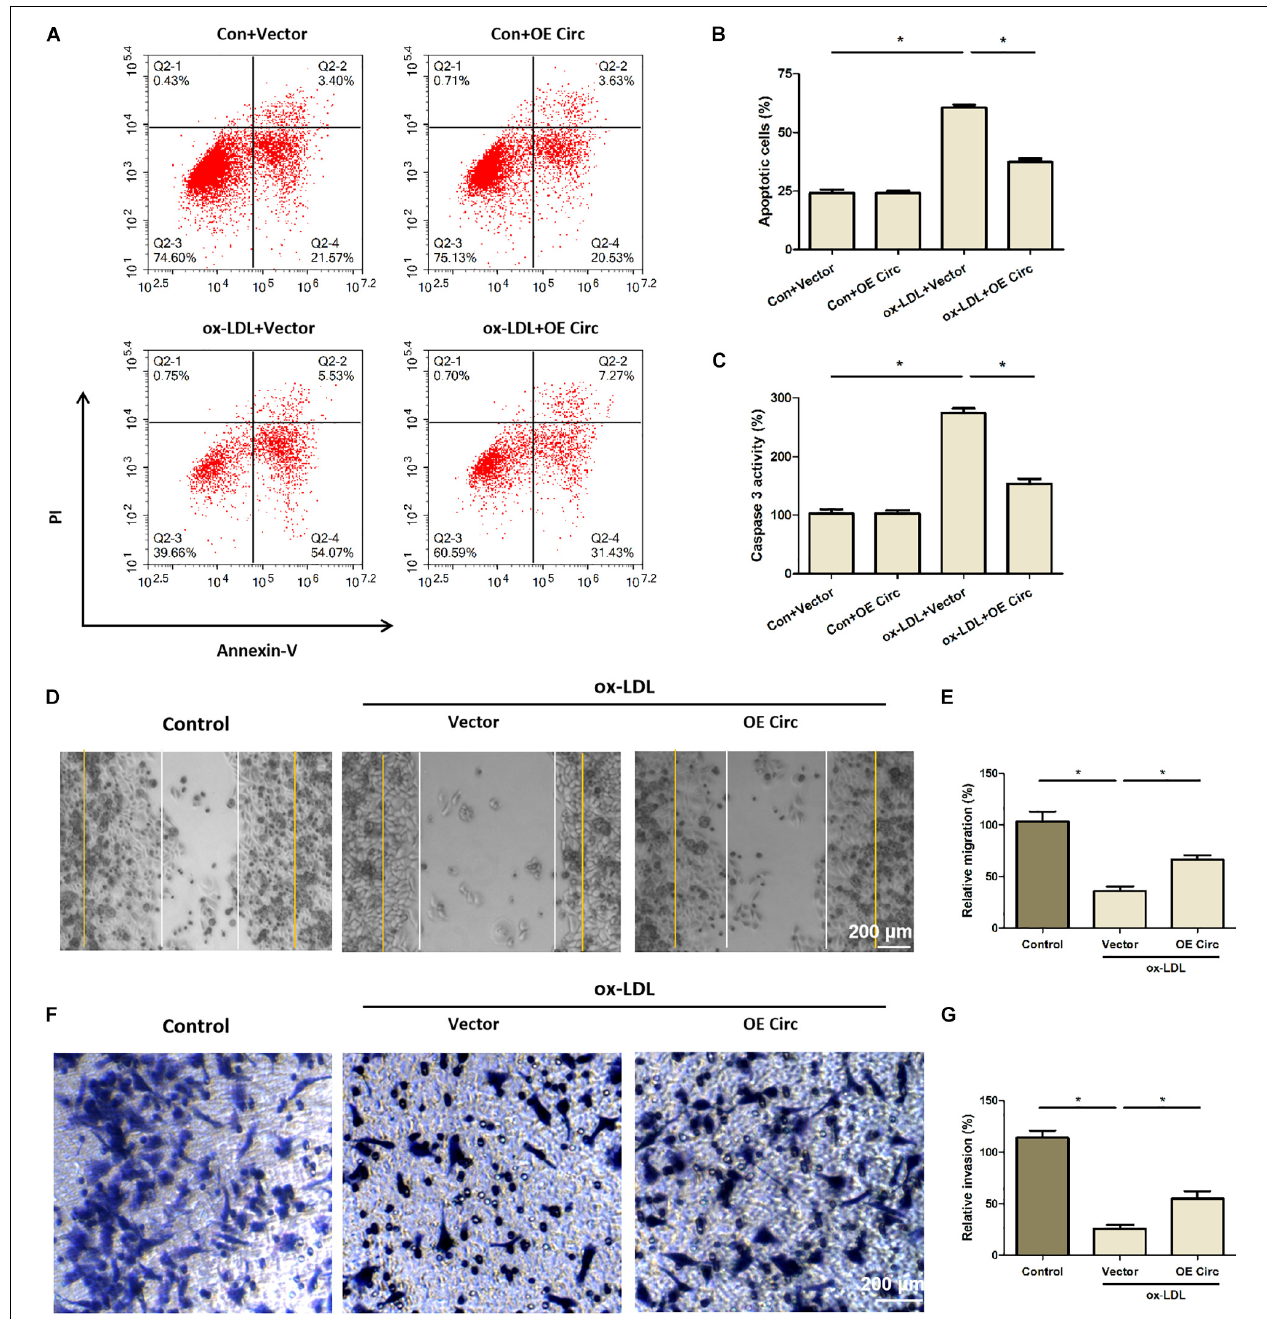
FIGURE 2 | Overexpression of circ_0065149 inhibited the apoptosis and promoted the migration and invasion of HUVECs treated with ox-LDL. (A,B) Apoptosis of HUVECs was measured by flow cytometry. * P < 0.05, ox-LDL + Vector vs. the Con-Vector group; ox-LDL + OE Circ vs. the ox-LDL + Vector group. (C) Caspase 3 activity assay. * P < 0.05, ox-LDL + Vector vs. the Con-Vector group; ox-LDL + OE Circ vs. the ox-LDL + Vector group. (D,E) Migration was detected by wound healing assay at 0 (yellow line) and 24 h (white line). Bar indicated 200 µ m. * P < 0.05, Vector vs. the Control group; ox-LDL + OE Circ vs. the ox-LDL Vector group. (F,G) Invasion was detected by Transwell assay. * P < 0.05, Vector vs. the Control group; ox-LDL + OE Circ vs. the ox-LDL Vector group. Data are shown as means ± SD .